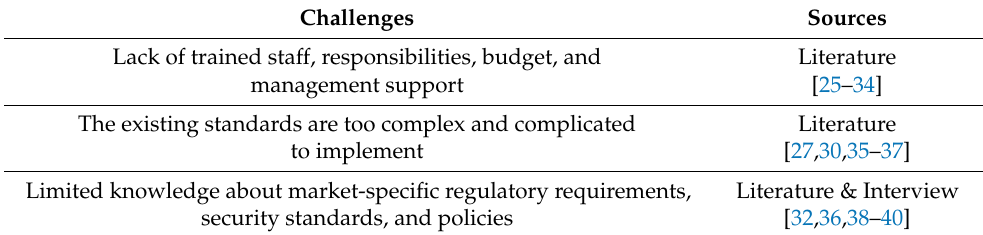
Table 1. List of